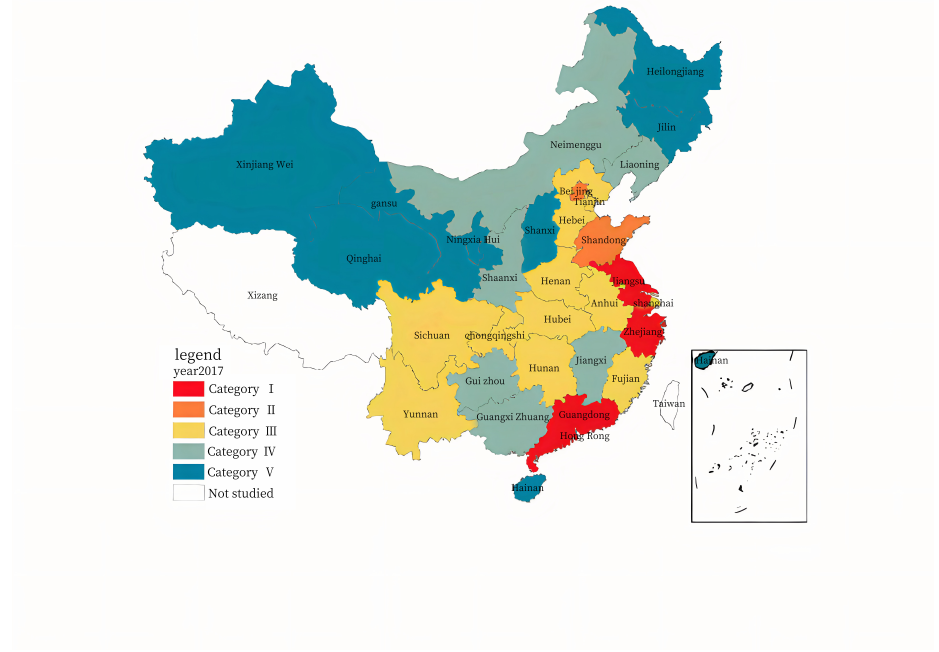
Figure 6. Spatial distribution for the RLGIL of the 30 provinces in